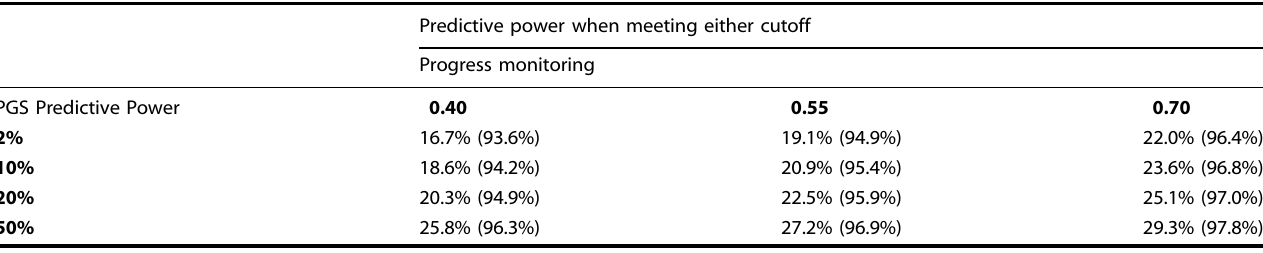
Table 3. Positive and negative predictive values of progress monitoring tools and PGS (meeting either ’ s criteria) as a screener for learning disabilities (tenth percentile or lower achievement).